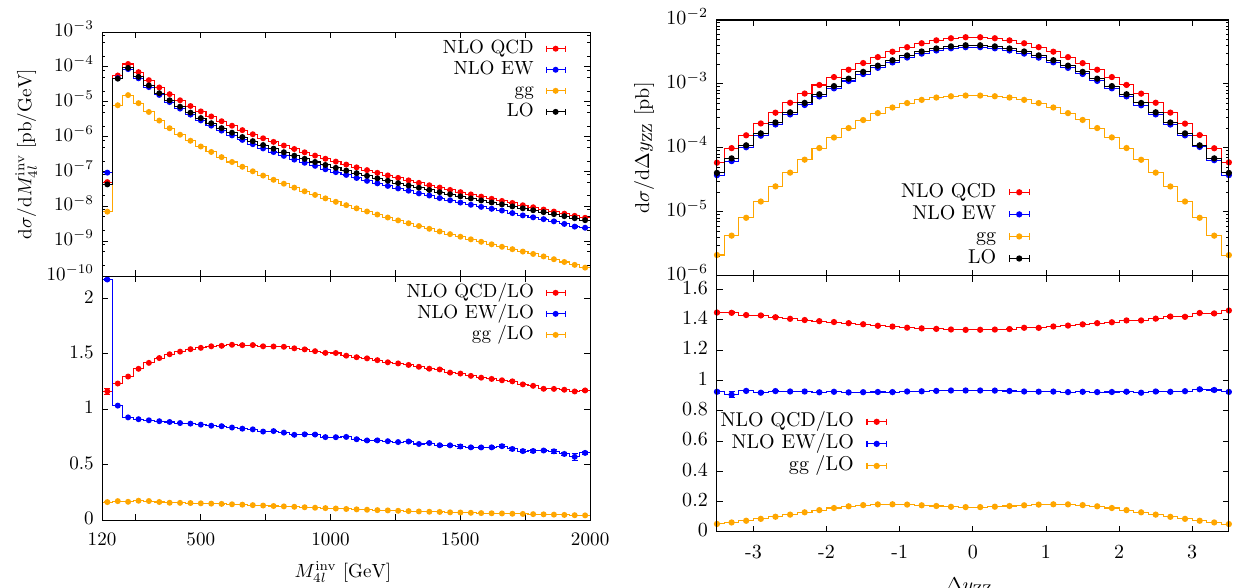
Fig. 18 Differential distribution in the four-lepton invariant mass ( M inv √ s = 13TeV under the event selections of Eq. (4.11). Same notations and conventions as in Fig. 16 e + e − μ + μ − at